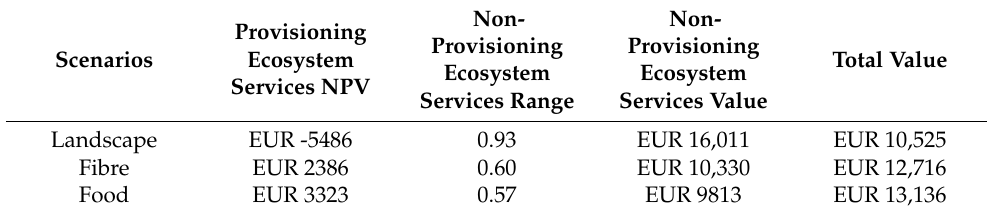
Table 2. The total value of the considered scenarios per ha (adapted from Krzemie´n et al. [1]).